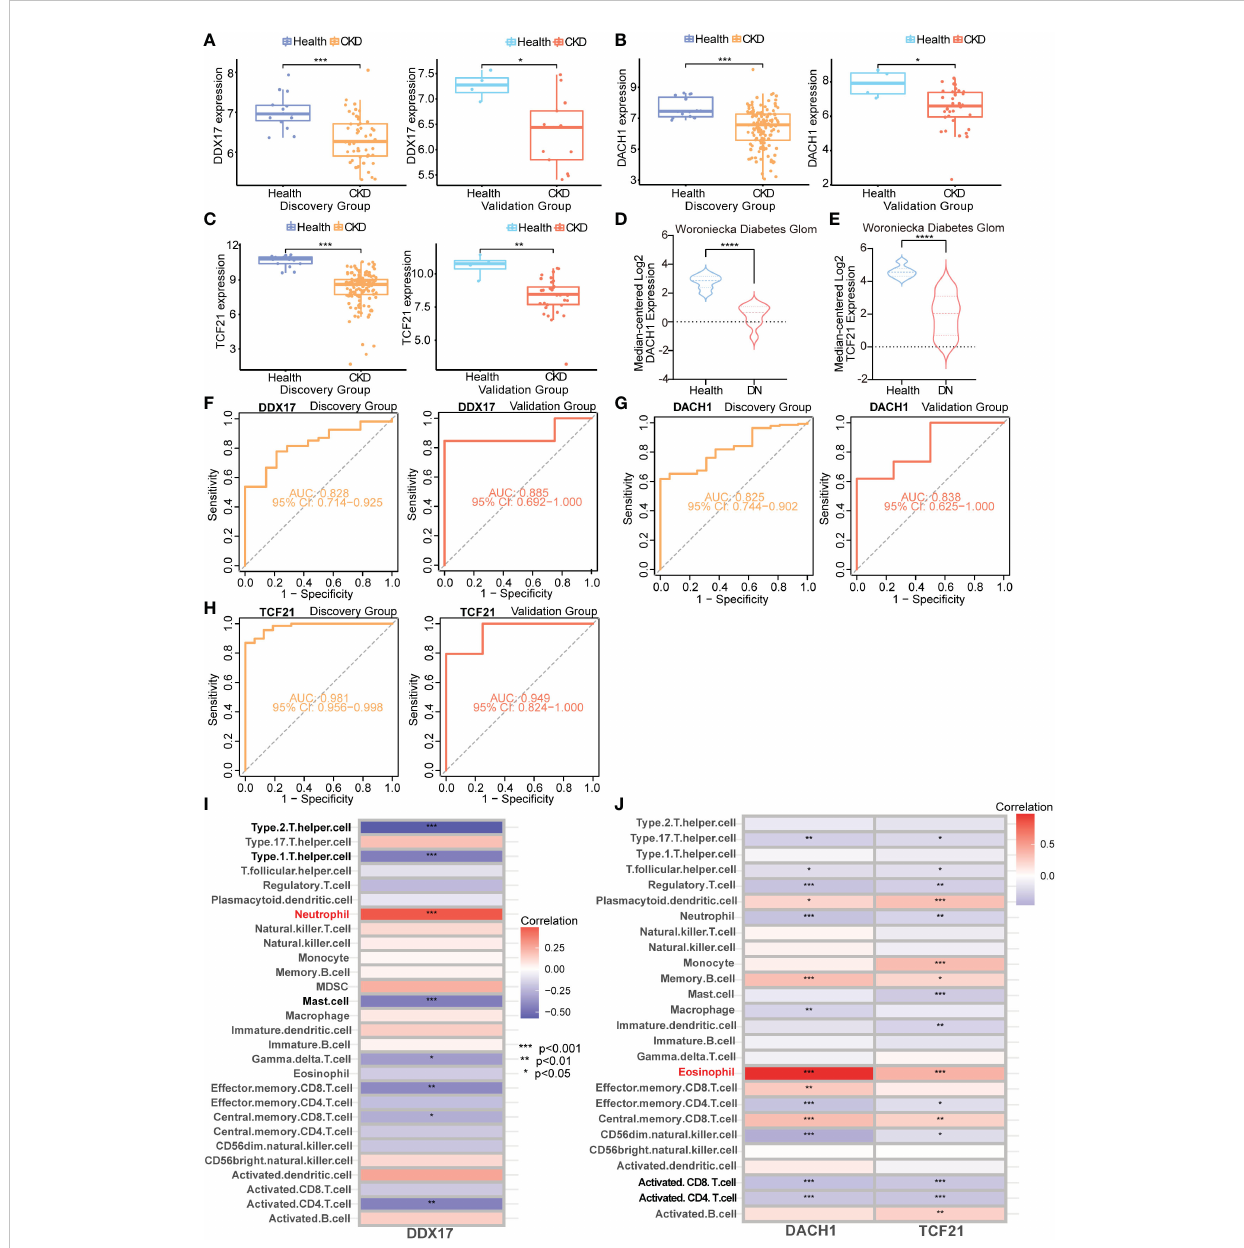
FIGURE 8 Validation and immune in fi ltration evaluation of CKD biomarkers from different samples (A – C) Box plots representing expression level of CKD genetic biomarkers in the discovery and validation cohorts. (D) mRNA level of DACH1 in the Woroniecka Diabetes Glom Cohort. (E) mRNA level of TCF21 in the Woroniecka Diabetes Glom Cohort. (F – H) Receiver operating characteristic (ROC) curve for the discovery and validation cohorts. (A, F) DDX17 (PBMC); (B, G) DACH1 (TISSUE); (C, H) TCF21 (TISSUE). (I) Correlation heatmap demonstrating the relationship between DDX17 (PBMC) and immune cells in fi ltration. (J) Correlation heatmap demonstrating the relationship between DACH1 and TCF21 (TISSUE) and immune cells in fi ltration. * P < 0.05; ** P < 0.01; *** P < 0.001; **** P <